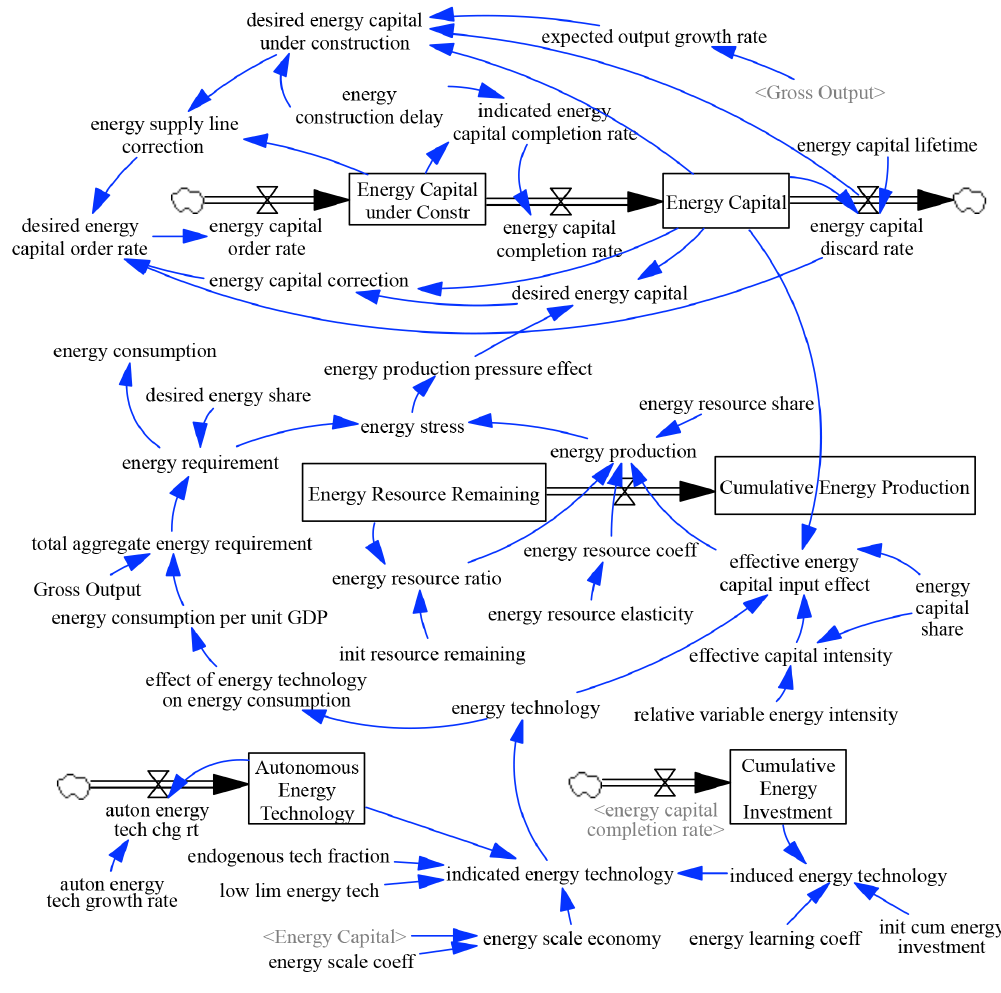
Figure 14. Stock and flow diagram of the energy sector. Table 1. Energy endowments in the Belt (tce: ton of standard coal equivalent, 1tce = 29.3 billion